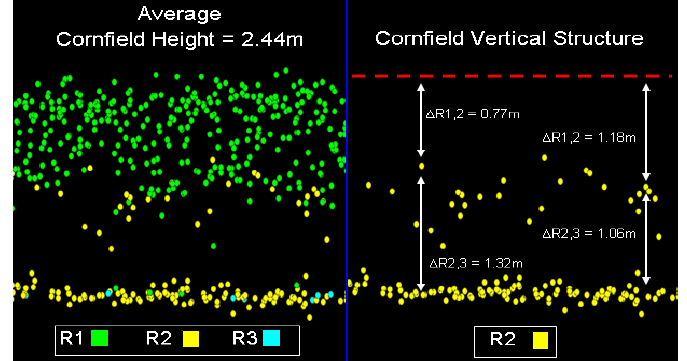
Figure 3. Color-coded representation of the confined vertical structure based on processed DR